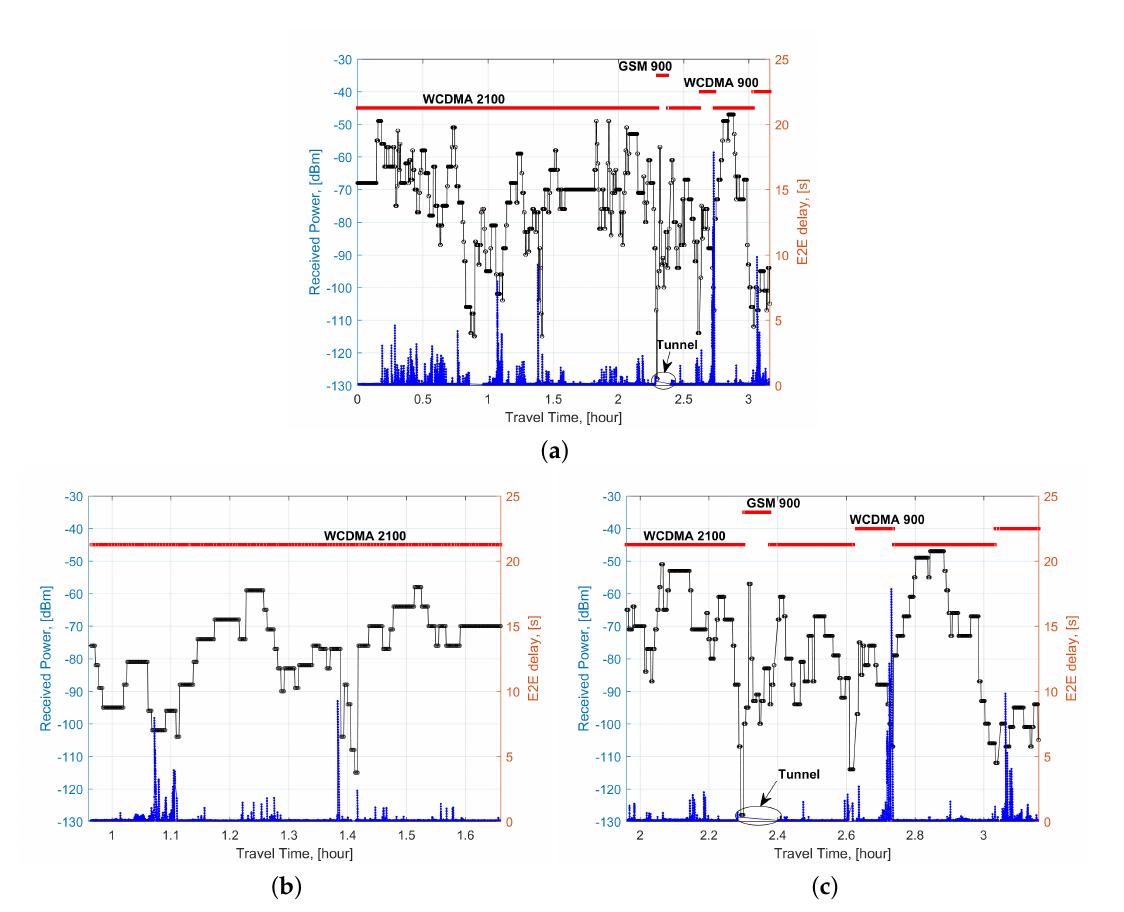
Figure 3. Example of the received power (left y − axis) and E2E delay (right y − axis) as a function of the travel time in ( a ). Corresponding zoomings are in ( b , c ). The red line indicates the duration of the time interval the train uses the radio technology as in the corresponding label (i.e., Wideband Code Division Multiple Access (WCDMA) 2100, WCDMA 900, GSM 900) for train to ground communications; the black line is the received power level measured by the on board terminal; the blue line is the measured E2E